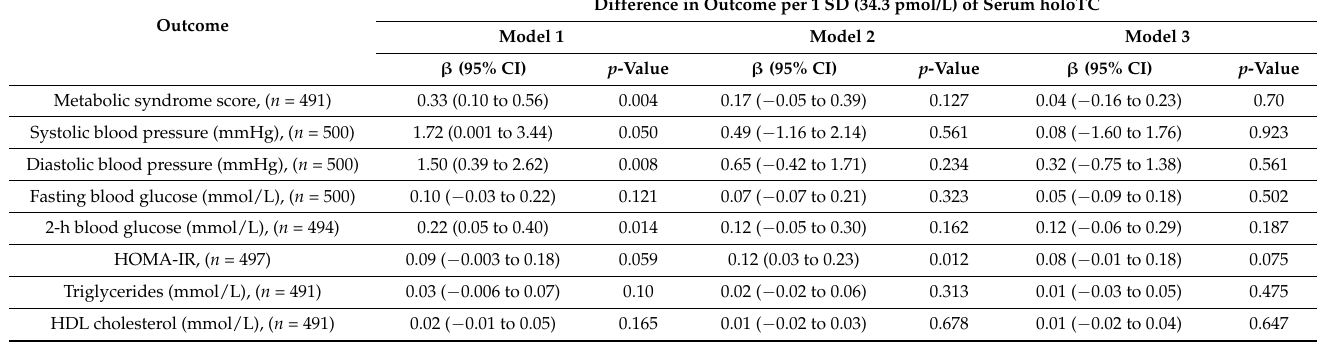
Table 3. Associations between serum holotranscobalamin (holoTC) and metabolic risk factors; Cameroon